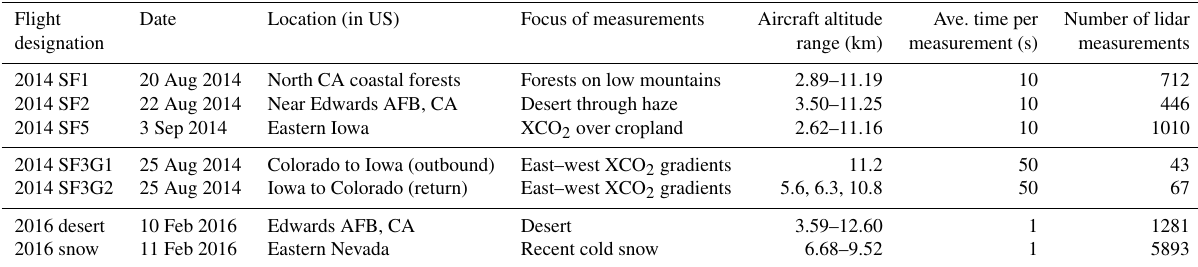
Figure 10. (a) Map of the 2014 SF1 flight track over the northern California coast on 20 August 2014. (b) Time-tagged location and altitude plot for the same flight. Table 2. Summary of 2014 and 2016 campaign flights and regions studied.